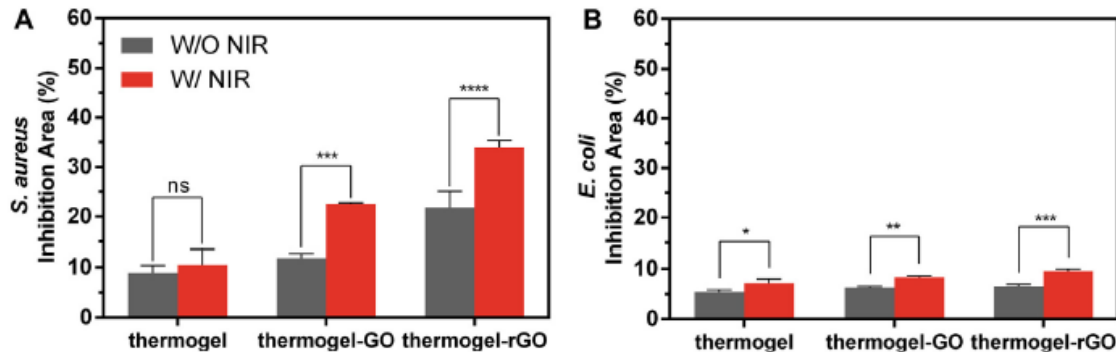
Figure 22. Characterization of the near-infrared (NIR)-light enhanced antibacterial activity of the different hydrogel for- mulations. Analysis of the inhibition area obtained for thermogel, thermogel–GO and thermogel–rGO in contact with S. aureus ( A ) or E. coli ( B ) without NIR (W/O NIR) or with NIR (W/ NIR) laser irradiation (808 nm, 1.7 W.cm −2 , 10 min). Values are presented as mean ± SD, n = 3. (* p < 0.05, ** p < 0.01, *** p < 0.001, **** p < 0.0001, ns = non-significant). Reprinted with permission. Copyright 2020, Elsevier [92].